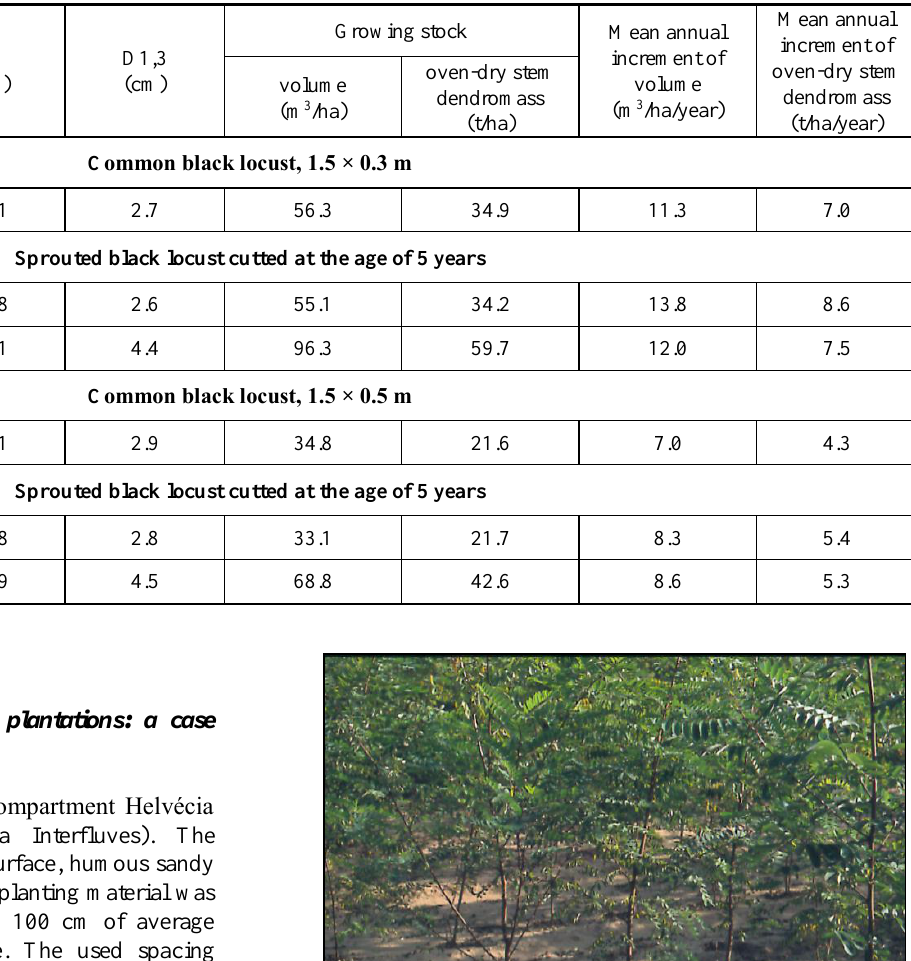
Table 1. Above-ground dendromass os coppiced black locust energy plantations